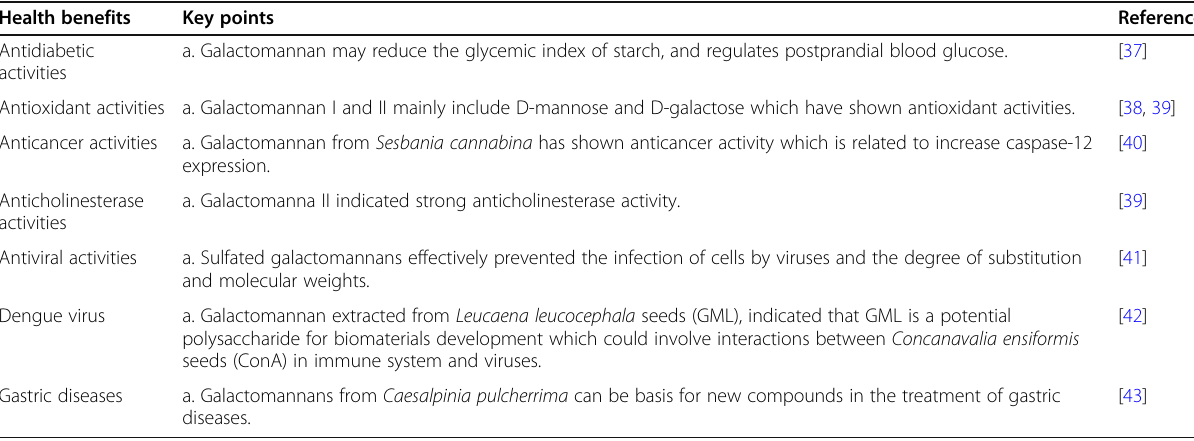
Table 1 The most important pharmacological effects of galactomannan